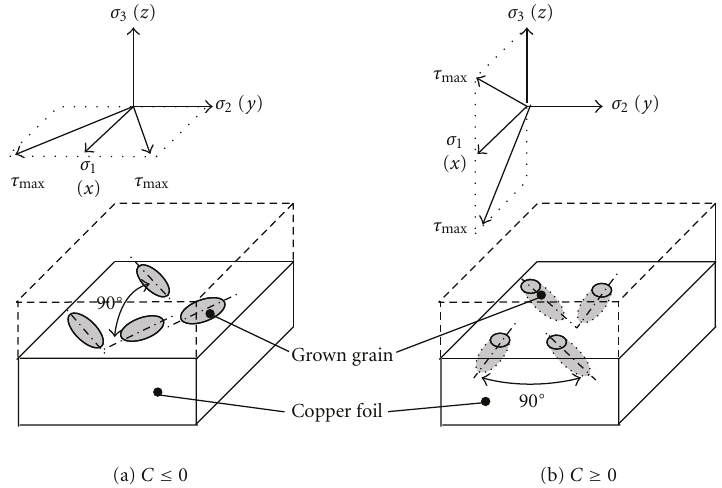
Figure 2: Schematic diagram of grain growth in copper foil.